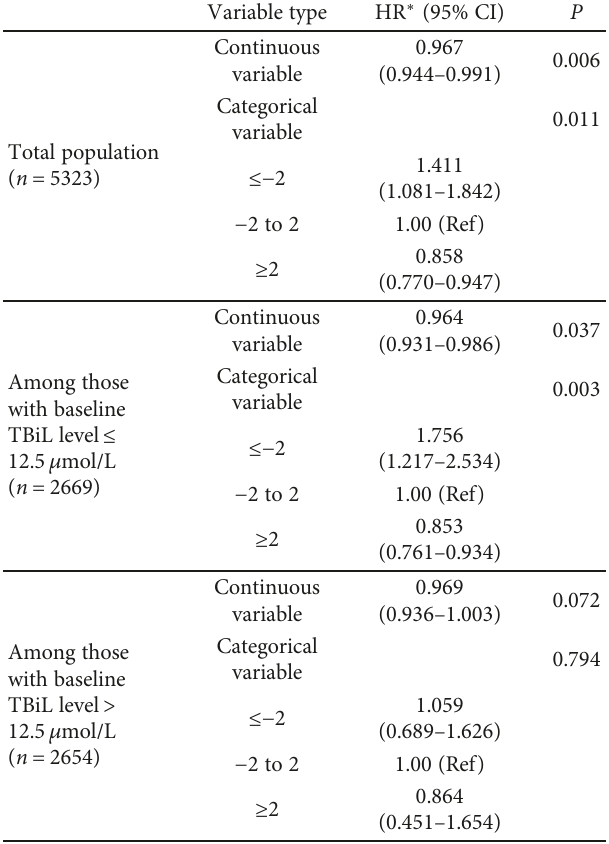
Table 4: HRs and 95% CI of DR incidence according to follow-up TBiL changes ( μ